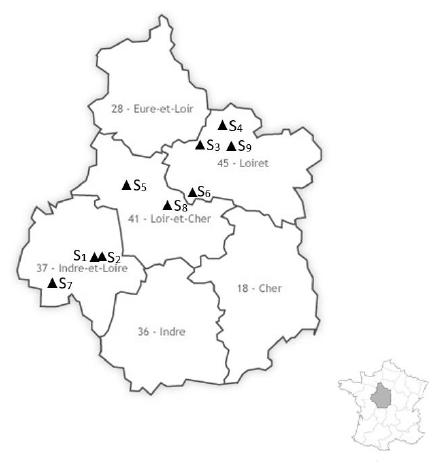
Figure 1. Location of the nine studied sites (S 1 to S 9 ) on the map of the Centre-Val de Loire region that comprises six departments: Cher (18), Eure-et-Loir (28), Indre (36), Indre-et-Loire (37), Loir-et- Cher (41), Loiret (45).